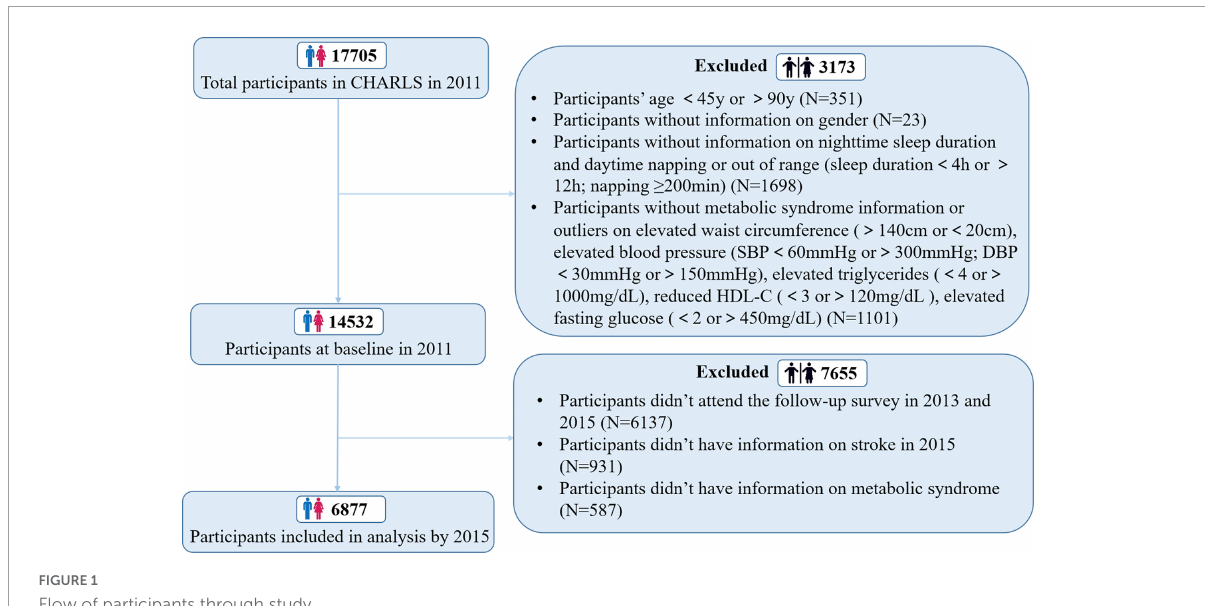
FIGURE1 Flow of participants through